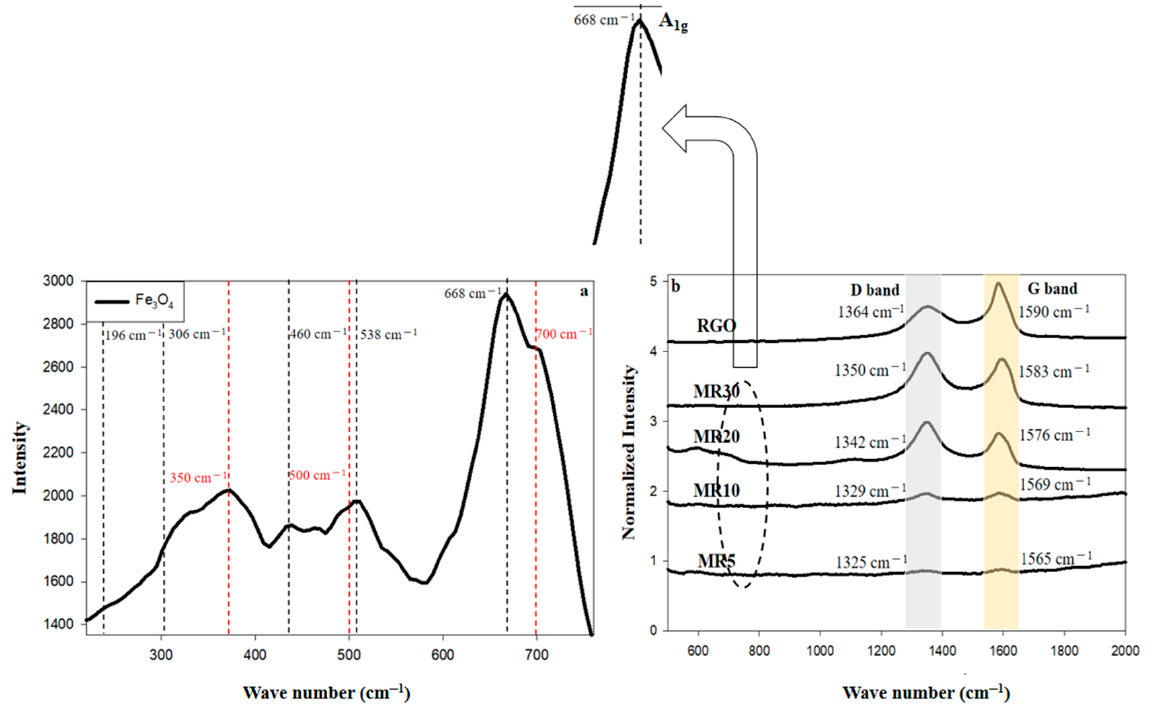
Figure 3. ( a ) The Raman spectrum for Fe 3 O 4 . ( b ) The Raman spectra for RGO, MR5, MR10, MR20 and MR30.